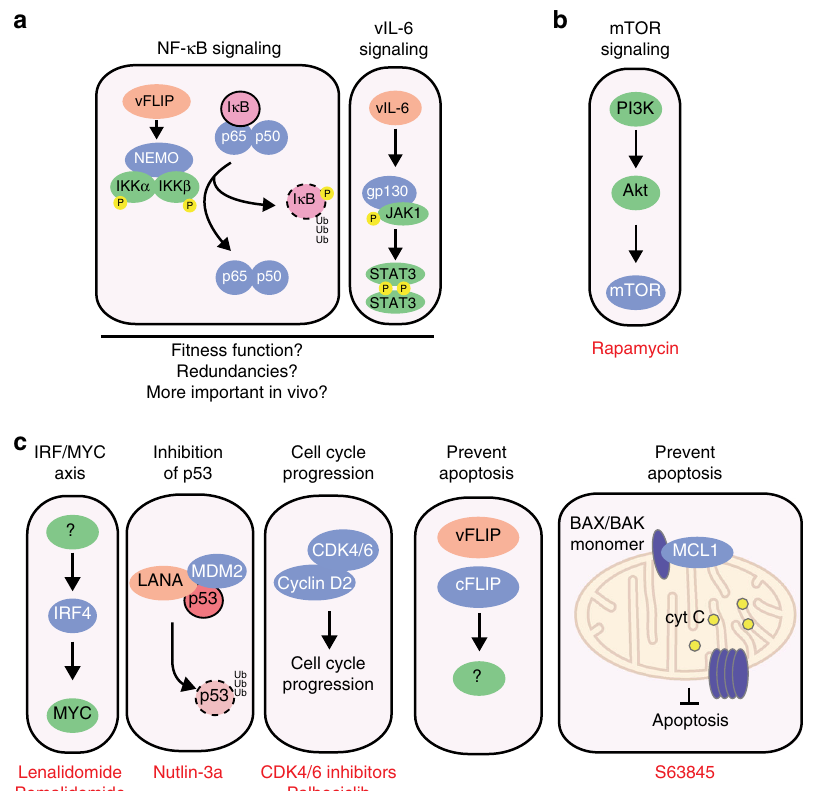
Fig. 7 Revised working model of the main host oncogenic gene dependencies in PEL cell lines. a Genes involved in NF- κ B and Jak/Stat signaling are dispensable in most PEL cell lines and may serve fi tness functions. b Addiction to constitutively active mTOR signaling was not captured in this study, due to confounding housekeeping function of mTOR. c Critical PEL-speci fi c oncogene dependencies (PSODs) on IRF4 , MDM2 , CCND2 , CFLAR , and MCL1 (in blue), most of which are druggable using agents shown in